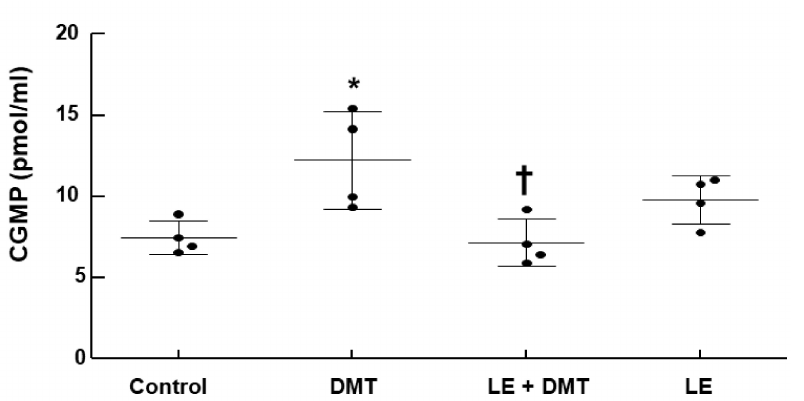
Figure 5. Effect of lipid emulsion (LE) on dexmedetomidine (DMT)-induced cyclic guanosine monophosphate (cGMP) formation in the isolated endothelium-intact rat aorta. Aortae were treated with DMT (10 − 7 M) for 5 min and with LE (1%) for 20 min, followed by treatment with DMT (10 − 7 M) for 5 min or LE (1%) alone for 25 min. Data ( n = 4) are shown as mean ± standard deviation. n indicates the number of rats. * p < 0.05 versus control. † p < 0.001 versus DMT alone. DMT (10 − 6 M) increased the stimulatory eNOS (Ser1177) phosphorylation (Figure 6A; p < 0.05 vs. control) in human umbilical vein endothelial cells (HUVECs), whereas LE (1% and 3%) inhibited DMT (10 − 6 M)-induced stimulatory eNOS (Ser1177) phosphory- lation (Figure 6A: p < 0.01 vs. DMT alone). DMT (10 − 6 M) decreased inhibitory eNOS (Thr495) phosphorylation in HUVECs (Figure 6B; p < 0.05 vs. control), whereas LE (1% and 3%) reversed the decreased inhibitory eNOS (Thr495) phosphorylation induced by DMT (Figure 6B; p < 0.01 vs. DMT alone). The alpha-2 adrenoceptor inhibitor rauwolscine (10 − 6 M) decreased DMT (10 − 6 M)-induced stimulatory eNOS (Ser1177) phosphoryla- tion (Figure 7; p < 0.001 vs. DMT alone) in HUVECs. Rauwolscine (10 − 6 M) alone in- hibited eNOS (Ser1177) phosphorylation (Figure 7; p < 0.05 versus control). Src kinase inhibitor 4-Amino-3-(4-chlorophenyl)-1-(t-butyl)-1H-pyrazolo[3,4-d]pyrimidine,4-Amino- 5-(4-chlorophenyl)-7-(t-butyl)pyrazolo[3,4-d]pyrimidine (PP2, 2 × 10 − 5 M) inhibited the in- creased stimulatory eNOS (Ser1177) phosphorylation induced by DMT (10 − 6 M) (Figure 8A; p < 0.05 vs. DMT alone) in HUVECs. However, PP2 (2 × 10 − 5 M) reversed DMT (10 − 6 M)- induced decreased inhibitory eNOS (Thr495) phosphorylation (Figure 8B; p < 0.001 vs. DMT alone). DMT (10 − 6 M) increased caveolin-1 (Tyr14) phosphorylation (Figure 9A; p < 0.01 vs. control), whereas PP2 (2 × 10 − 5 M) inhibited DMT (10 − 6 M)-induced caveolin-1 (Tyr14) phosphorylation (Figure 9A; p < 0.001 vs. DMT alone). DMT (10 − 6 M) induced Src kinase (Tyr416) phosphorylation in HUVECs (Figure 9B; p < 0.01 vs.